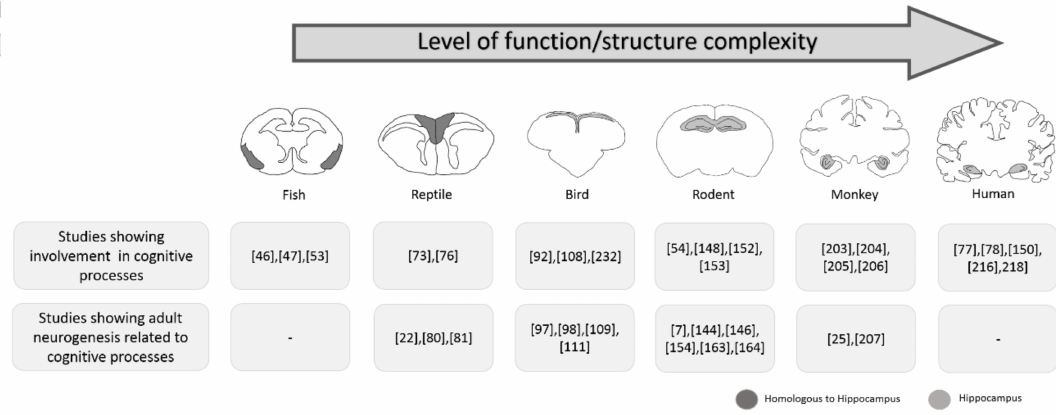
Figure 1. Schematic representation of hippocampal anatomic differences among species and studies showing involvement of these areas in cognitive processes (first line) and adult neurogenesis in these areas related to cognitive processes (second line). Although clear anatomical similarity only exists between the hippocampi of mammals, evidence points to a functional similarity with other species, such as fish or reptile, with less complex brain structure/function in general for cognitive processes such as memory, learning and future planning, among others (cognitive complexity). The birth of new neurons in adult mammals is mostly restricted to the hippocampal dentate gyrus. Although there are many neurogenic zones in other species, areas homologous to the hippocampus always appear among them, suggesting some similarity in the functions of these new neurons in cognitive processes in all species. Although a dense body of information points to similarities in function, it was suggested recently that the adult human brain does not retain the neurogenic capacity, raising intense debate about the possible impact on the way the human brain handles receiving, storing, and processing new